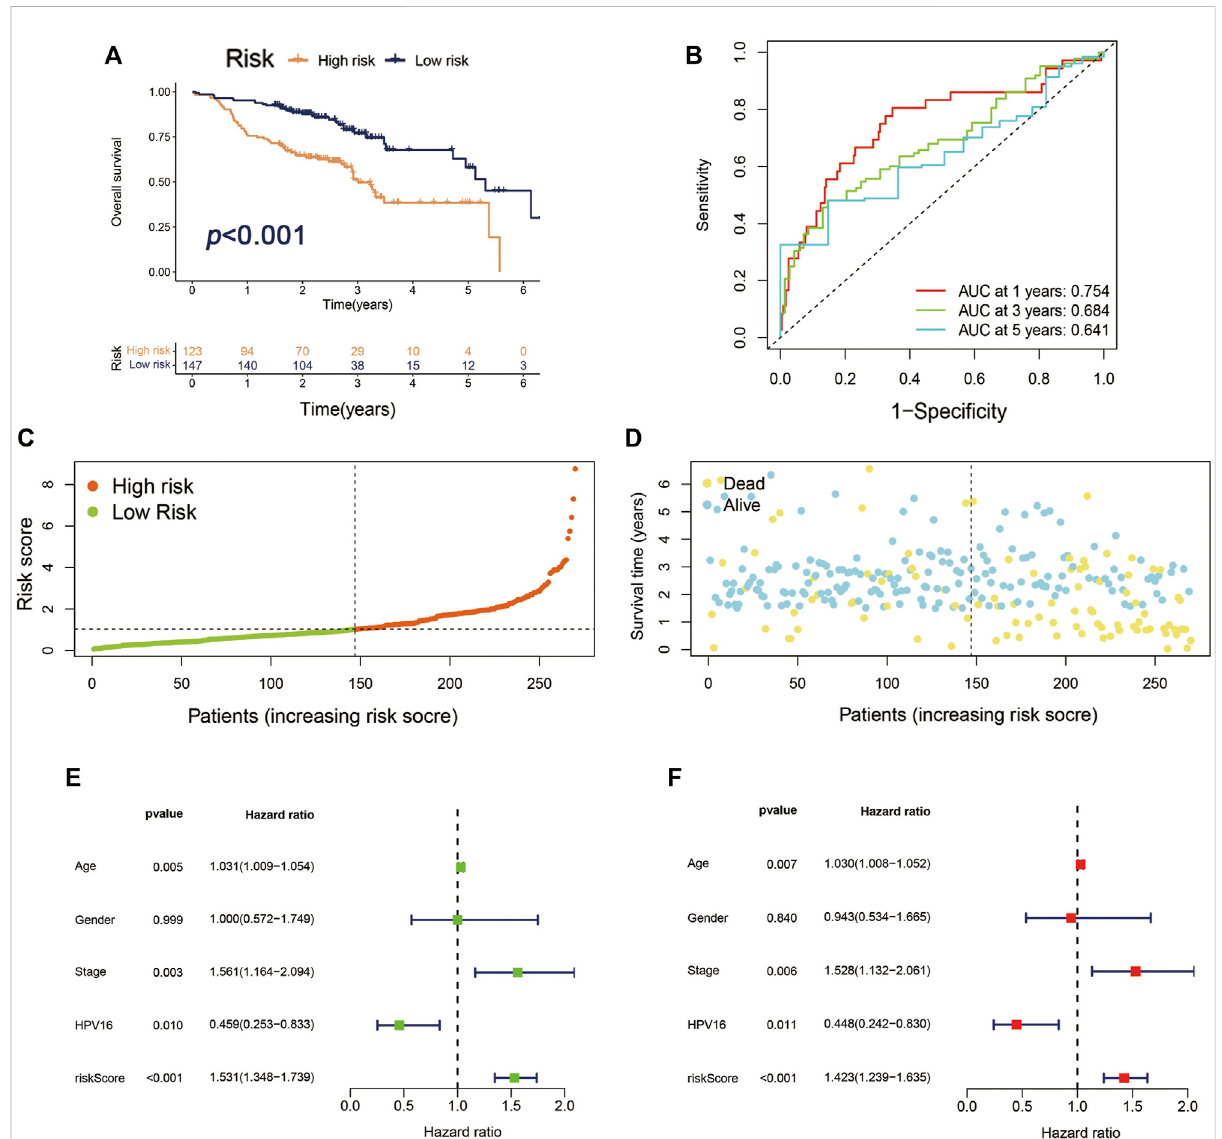
FIGURE 5 ValidationofCupr-RLPSofGSE65858cohort. (A) K – Mcurvesshowedthesigni fi cantdifferentOSoutcomesbetweenthehigh-riskandlow-risk groups. (B) AUC values showed 1, 3, and 5 years ’ predictions in the cohort. (C) The risk score distribution plot displayed the patients ’ distribution in high risk and low risk in the cohort. (D) The Scatter plot manifested the relationship between the survival status and the risk scores in high-risk and low-risk groups. (E) Univariate and (F) multivariate Cox regression analysis further indicated that the signature was an independent